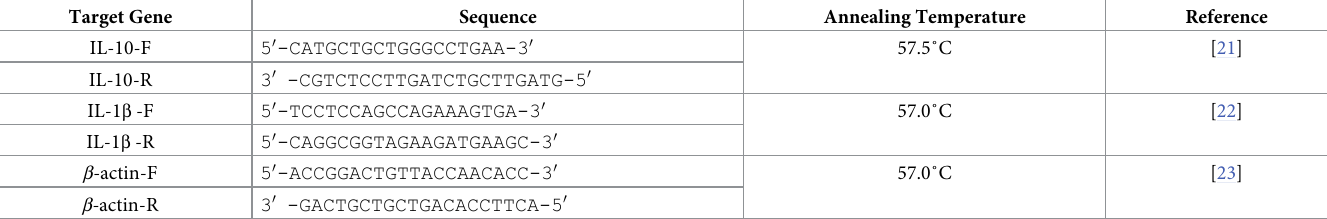
Table 1. Primers and PCR conditions for RT-PCR. Target